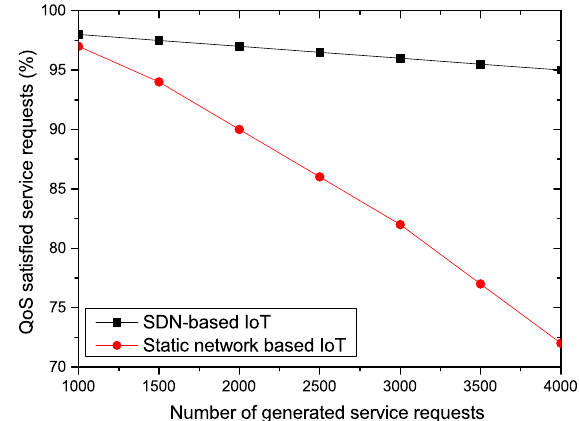
Figure 3. Percentage of QoS satisfied service requests vs